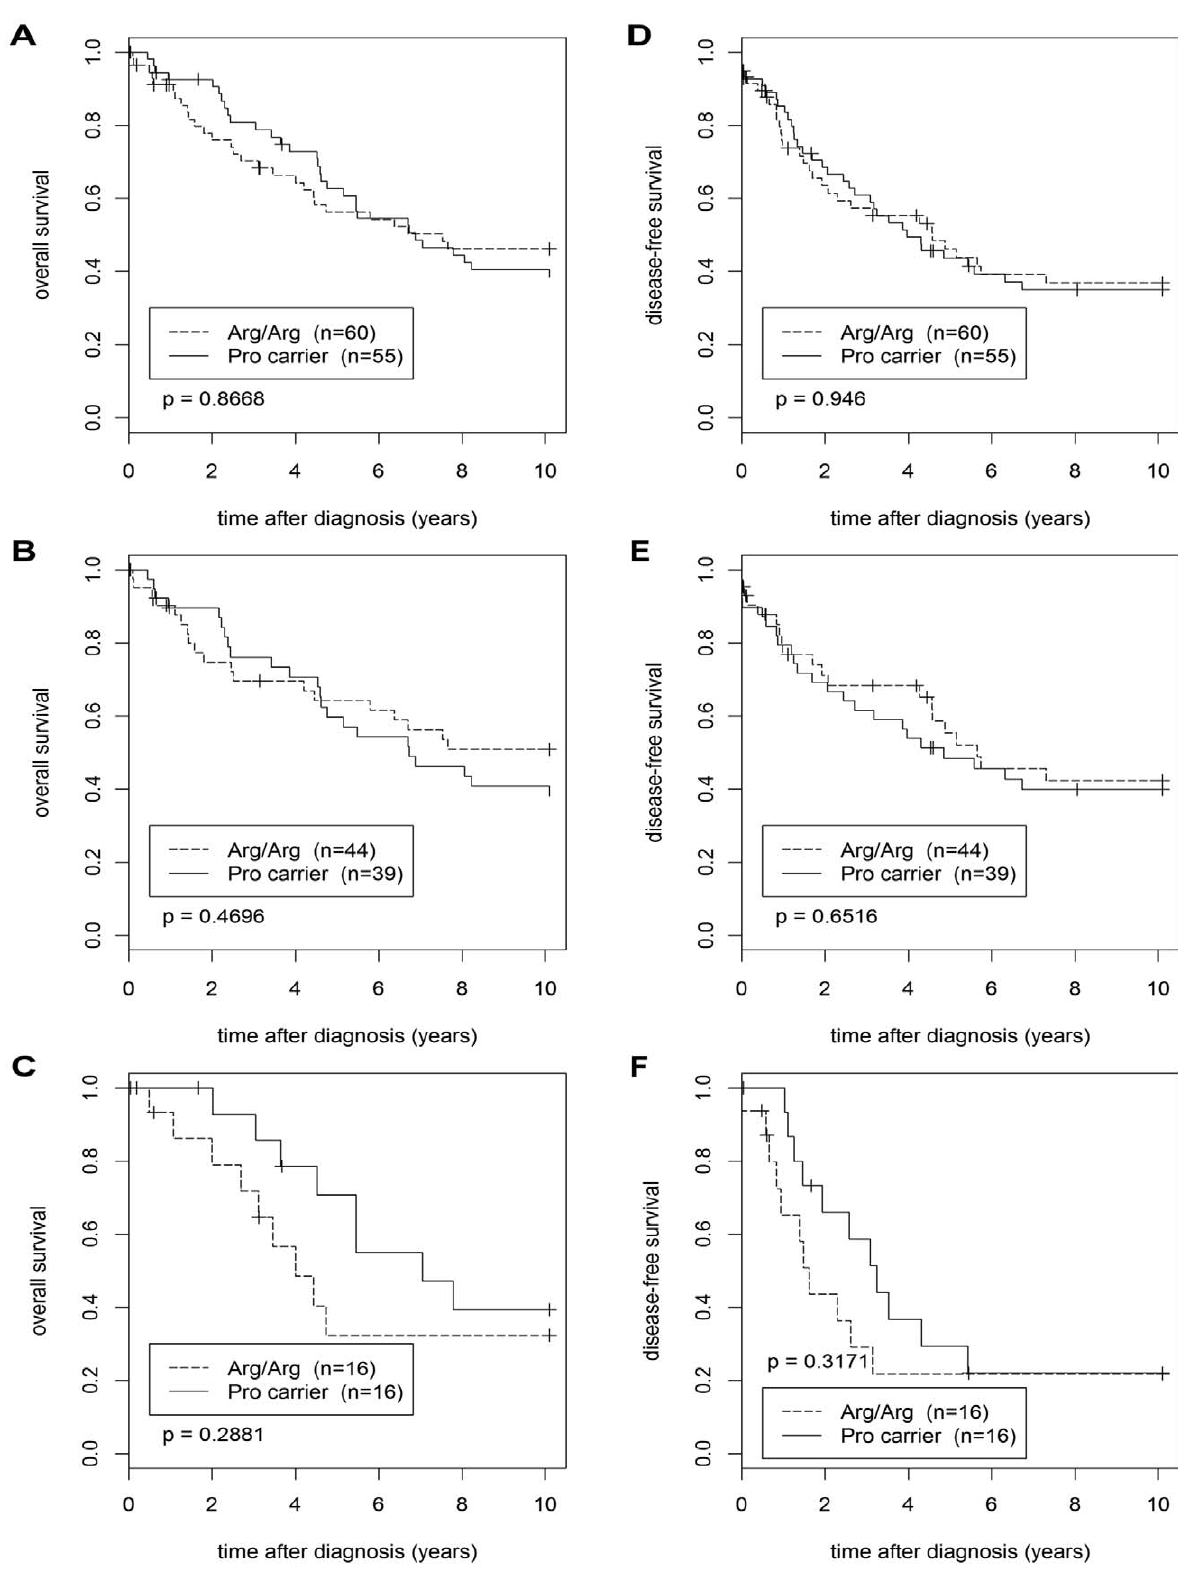
Figure 3. Kaplan-Meier analyses of the overall and disease-free survival. Overall survival ( A–C ) and disease-free survival ( D–F ) of patients with the Arg/Arg genotype and of Pro-allele carriers was compared. Kaplan-Meier analyses for unselected patients ( A, D ), patients with TP53 wildtype tumors ( B, E ), and patients with mutated TP53 in their tumors ( C, F ) are shown.